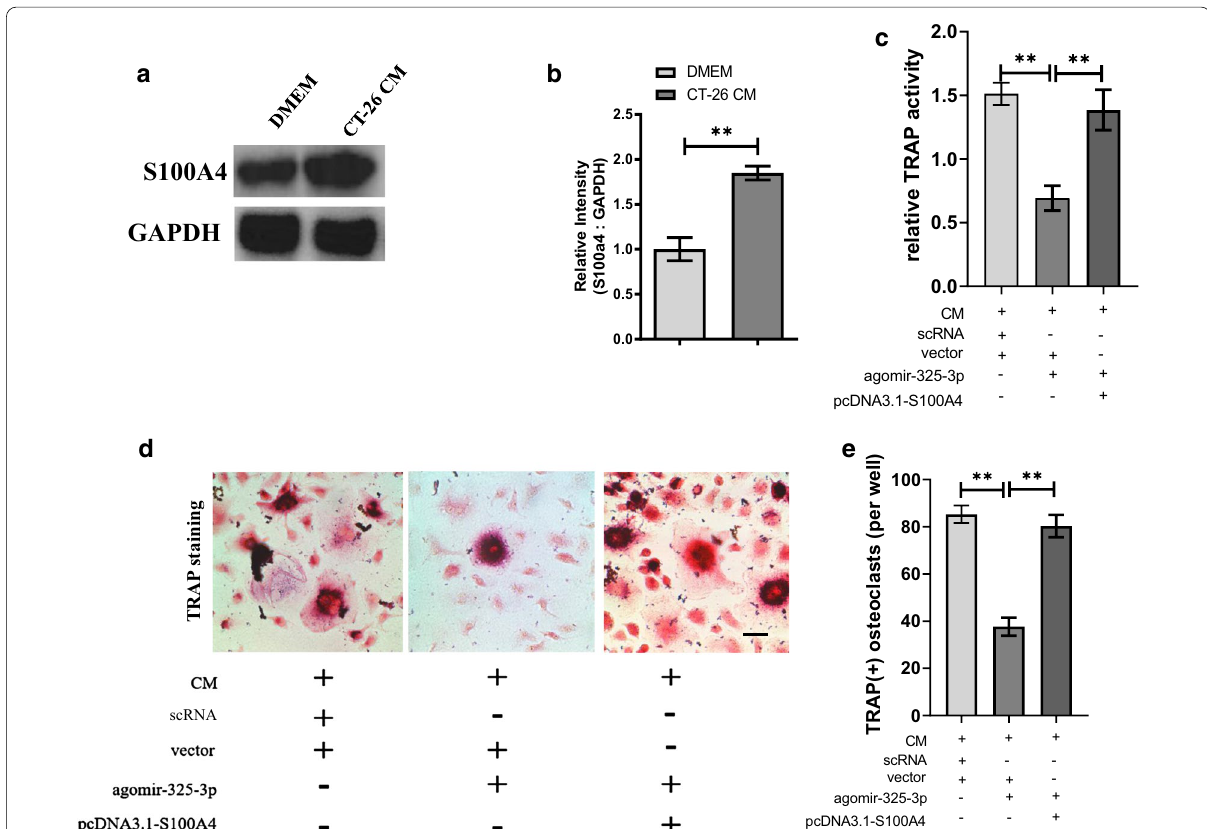
Fig. 4 S100A4 is needed for miR-325-3p mediated downregulation of osteoclast formation in CRC microenvironment. a OCPs were treated by DMEM or CT-26 CM for 4 days in the presence of RANKL and M-CSF. The protein level of S100A4 in OCPs were analyzed by using Western blot assay. b The relative intensity of S100A4 comparing with GAPDH in ( a ) was quantified (mean SD). c OCPs were transfected with agomir-325-3p or ± agomir-325-3p with plasmid containing S100A4 and cultured in CM for 4 days in the presence of RANKL and M-CSF. Relative TRAP activity in each group was analyzed (mean SE). d Representative images for osteoclastogenesis of OCPs cultured in CM after transfection with agomir-325-3p or ± agomir-325-3p with plasmid containing S100A4 in the presence of RANKL and M-CSF (Scar bar 10 μm). TRAP positive multinucleated cells with = more than three nuclei in each group were counted as mature osteoclasts. e The number of osteoclasts in ( d ) was qualified (mean SD). In vitro ± experiments were performed at least 3 times. *p < 0.05, **p < 0.01, ***p <